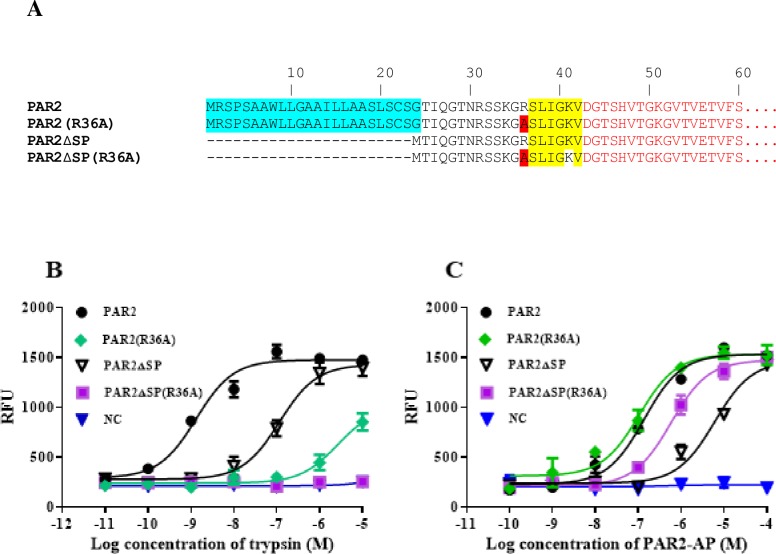
Arg36 to Ala mutation helps the functional expression of PAR2 without a signal peptide.A. schematic diagram showing the modifications/mutations to PAR2 receptor. The N-terminal extracellular sequences of various PAR2 mutants are shown. PAR2 wild type (PAR2), PAR2 with a Arg36 mutation to Ala (PAR2(R36A)), PAR2 with the signal peptide deleted (PAR2ΔSP), PAR2 with the signal peptide deletion and with an Arg36Ala mutation (PAR2ΔSP(R36A)) were used for characterizations. The signal peptide of PAR2 is shown in blue. The tether ligand sequence of PAR2 (SLIGKV) is highlighted in yellow. The mutation Ala residue from Arg36, which is involved in trypsin cleavage/activation of PAR2, is highlighted in red. The mutant receptors were characterized in FLIPR assays using either trypsin (B) or PAR2-AP (C) as ligands. HEK293 cells with par1 and par2 genes knocked-out were used as the host cells for recombinant expression. Untransfected cells were used as the negative controls (NC). The experiments were performed in triplicates at each data points and the results shown are mean ± sd. The experiments have been performed 3 times and very similar results have been observed. Example data is shown.